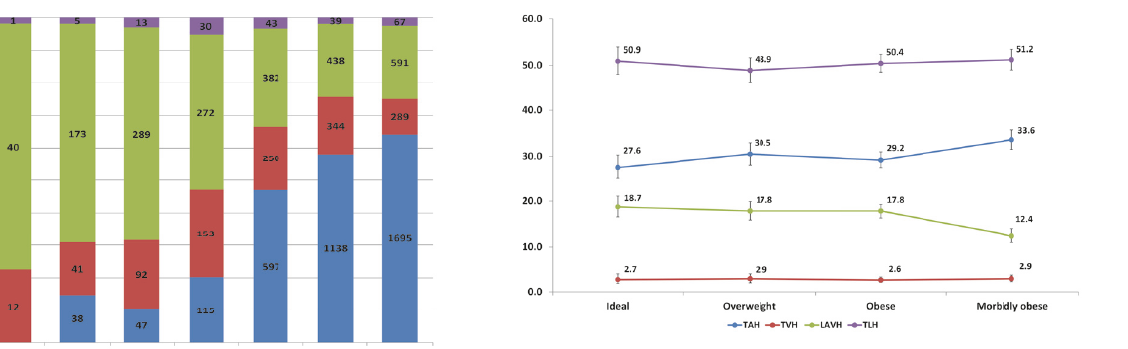
Figure 3: Rates of different types of hysterectomy performed among patients with a diagnosis of uterine cancer, by patient’s body mass index, ACS-NSQIP,